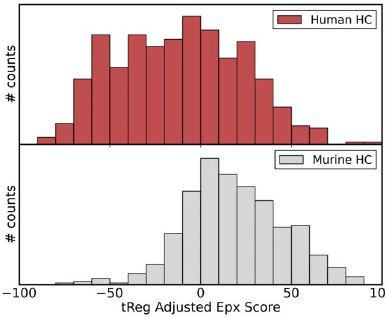
Figure 3. Stochastic Humanization of Rituximab-VH. Humaniza- tion of a murine heavy chain can be treated as an optimization of the objective function F Hh . The Monte Carlo algorithm starts from the sequence of Rituximab-VH and optimizes the scoring function and the sequence identity to the parental sequence simultaneously.